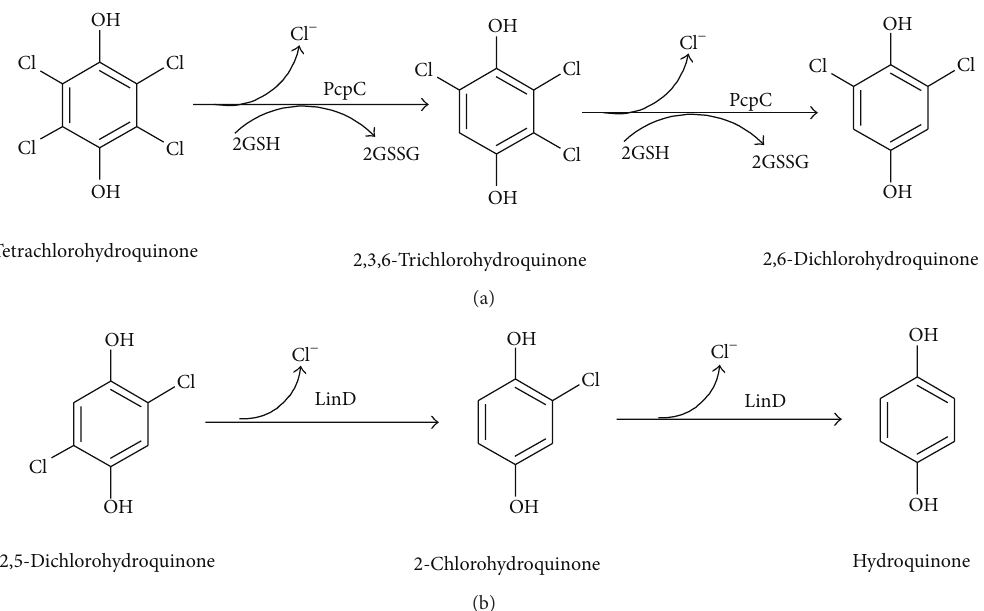
Figure 2: Reductive dehalogenation of (a) tetrachlorohydroquinone by a tetrachlorohydroquinone dehalogenase (PcpC) and (b) 2,5- dichlorohydroquinone by a 2,5-dichlorohydroquinone dehalogenase (LinD).